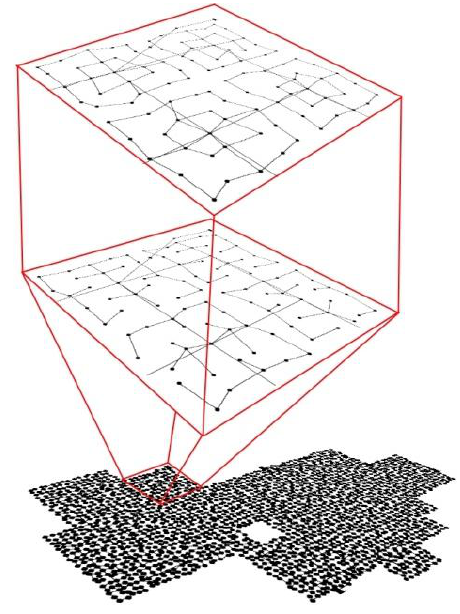
Figure 4. Different refinement strategies of an MDS model with a looped structure (top) or a branched structure (middle).